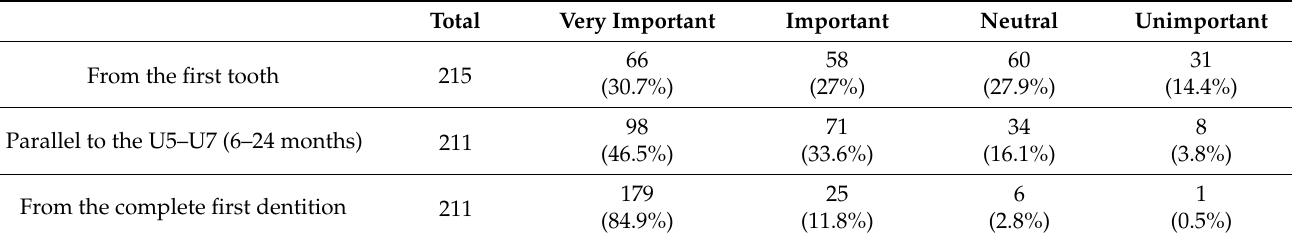
Table 3. Perceived significance of early dental visit by age group in absolute values and in percentages (%). Total Very Important